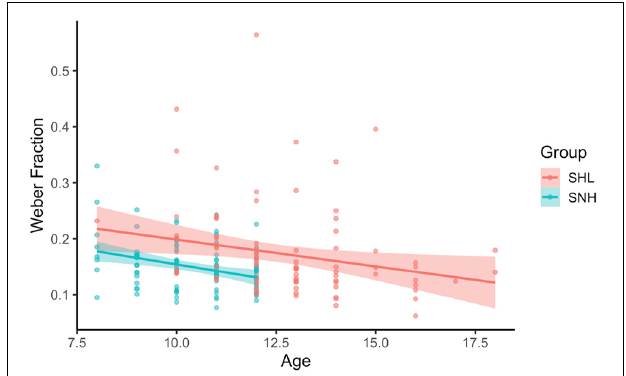
FIGURE 4 | Weber fractions by group membership and size-congruity. Weber fractions were lower (corresponding to more precise responses) when subjects were responding to size-congruent trials than when they were responding to size-incongruent trials. Also, SNH had higher acuity than SHL. There was no interaction between these two variables. Error bars represent standard error.